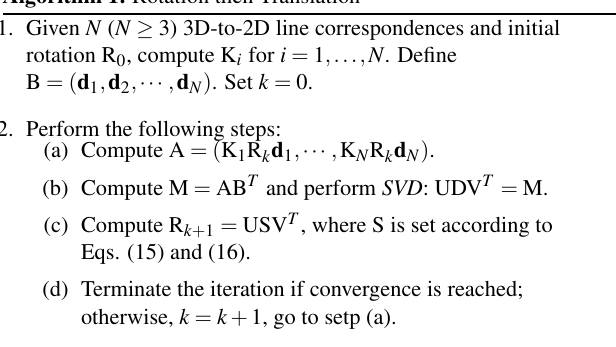
Algorithm 1: Rotation then